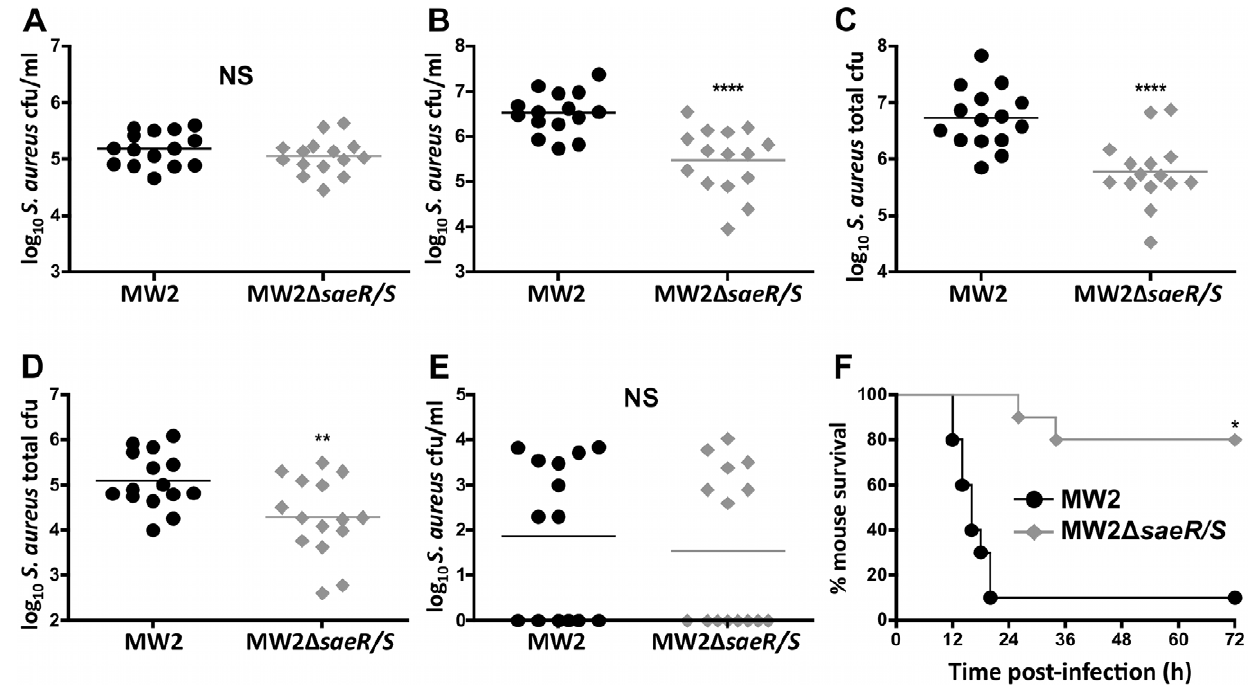
Figure 1. SaeR/S promotes bacterial persistence and host mortality in a mouse model of S.aureus peritonitis. Mice were inoculated i.p. with MW2 or MW2 D saeR/S (5 6 10 7 cfu) for (A) 4 hours and ( B – E ) 10 hours. ( A ) S. aureus burden in the peritoneal exudate, NS. For data in ( A ), results are from 3 biological replicates of 5 mice/group (n=15). ( B ) S. aureus burden in peritoneal exudate, **** P , 0.0001. ( C ) S. aureus burden in the kidneys, **** P , 0.0001. ( D ) S. aureus burden in the heart, ** P , 0.01. E , S. aureus burden in the blood, NS. For data in ( B – E ), results are from 2 biological replicates of 7 and 8 mice/group (n=15). All tissues compared were individually analyzed by t test. ( F ) Survival curve for mice inoculated (i.p.) with 5 6 10 7 cfu of MW2 or MW2 D saeR/S , * P , 0.001 as determined by logrank test (n=10/group). Mice receiving PBS had no S. aureus cfu (data not shown). NS=not significant.